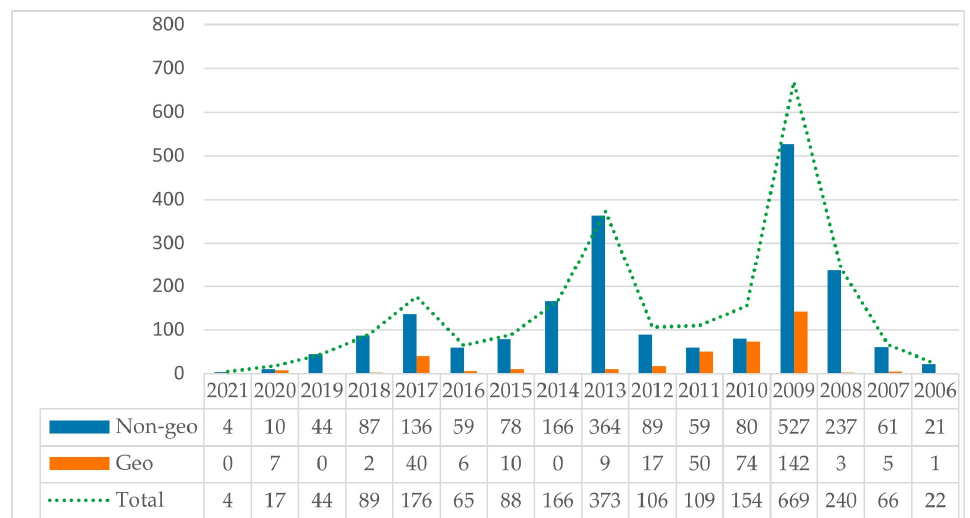
Figure 4. Statistics for geodata and non-geodata images according to image taken_date.